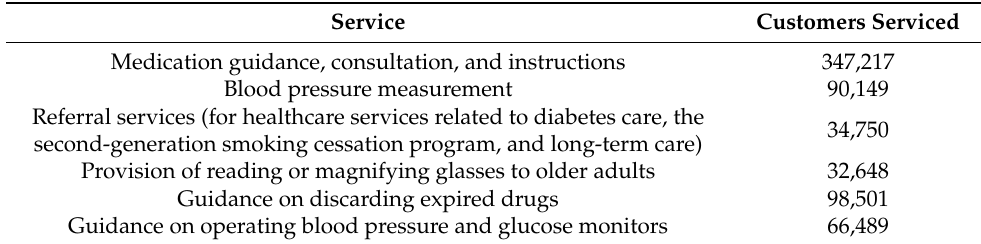
Table 1. Number of times of customer service provided by age-friendly